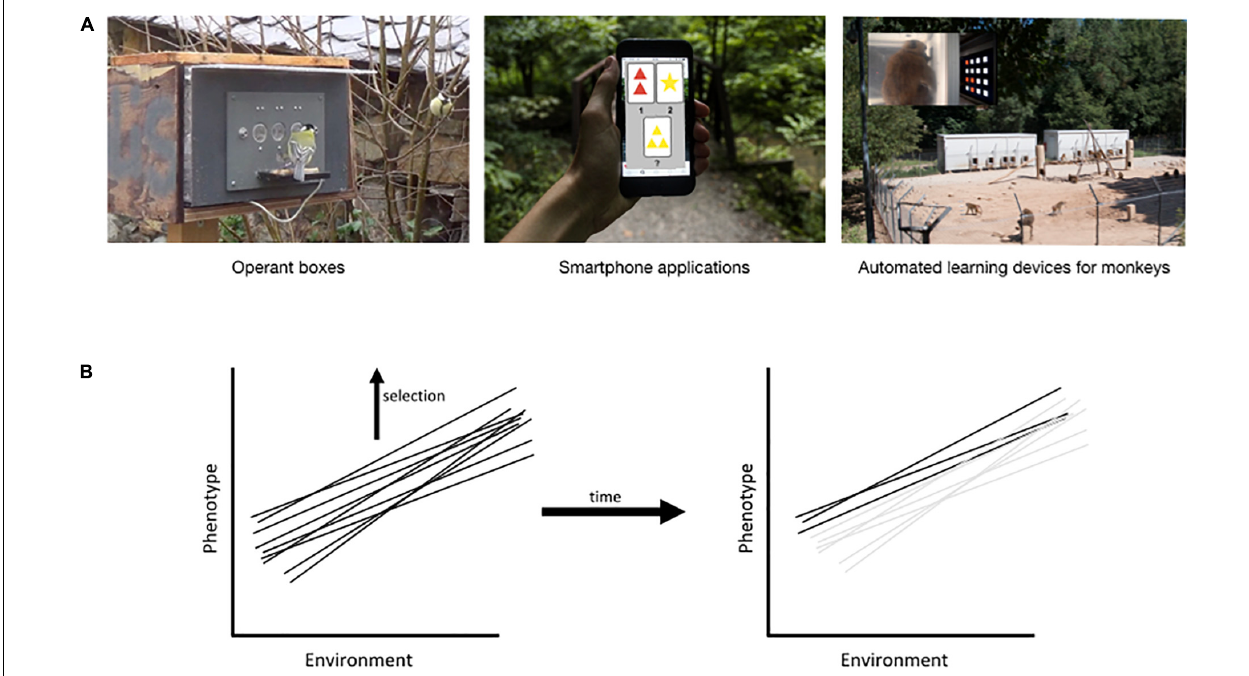
FIGURE 2 | Methods to study plasticity in cognitive performance and its adaptive value (i.e., evolution of reaction norms). (A) Automated cognitive testing devices can gather repeated data from the same individual in natural contexts. Examples include operant boxes to study associative and reversal learning in wild birds (Morand-Ferron et al., 2015; Cauchoix et al., 2017), smartphone applications for cognitive tasks (e.g., executive function task), and automated learning devices for monkeys: ALDM (Fagot and Bonté, 2010; Claidière et al., 2017). (B) Plasticity can then be described by linear (or non-linear; e.g., Figure 1A ) reaction norms. Selection can act on phenotypically plastic traits just as with normal traits except that selection will act on the reaction norm rather than a specific trait over the long term. Here we illustrate a population of genotypes that show a plastic expression of the phenotype across different environments (each line), and if selection favors increased values of the phenotype, the reaction norms that produce lower phenotypes will be eliminated over time. Note that selection can act primarily in one environment and therefore on the phenotype expressed in that environment, regardless of expression in other environments. Under such conditions, selection could be less efficient or slower in causing population change. In the case of cognition, the variety of expressions possible for an organism that is frequently in different environments could cause selection to act much more quickly on the shape of the reaction norm rather than exclusively on expression in one